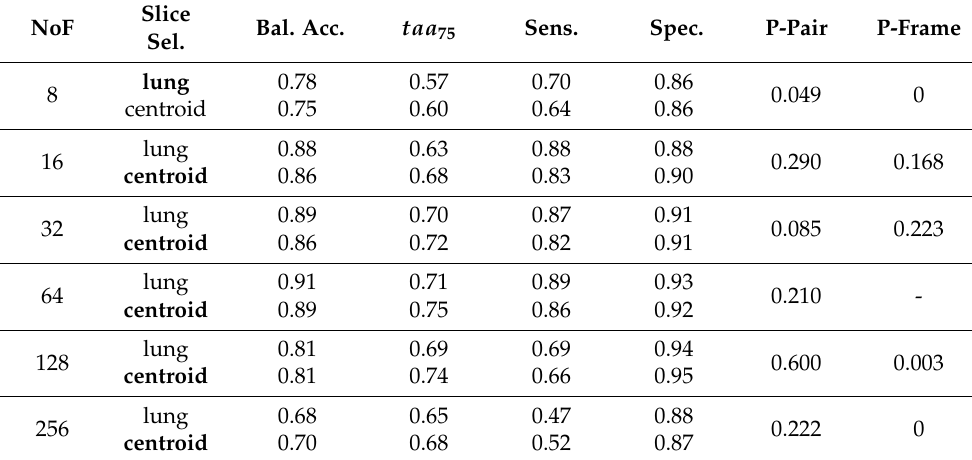
Table 3. Average video classification performance metrics of automated M-mode classification with different numbers of input frames and different slice selection methods. (NoF: Number of frames; Slice sel.: Slice selection method according to Section 2.2.2; Bal. Accuracy: Balanced accuracy; taa 75 : Thresholded aggregated accuracy according to Section 2.3; Sens.: Sensitivity; Spec.: Specificity; P-pair: p -value of the paired two-sided permutation test for slice selection method; P-frame: p -value of two-sided permutation test against the best